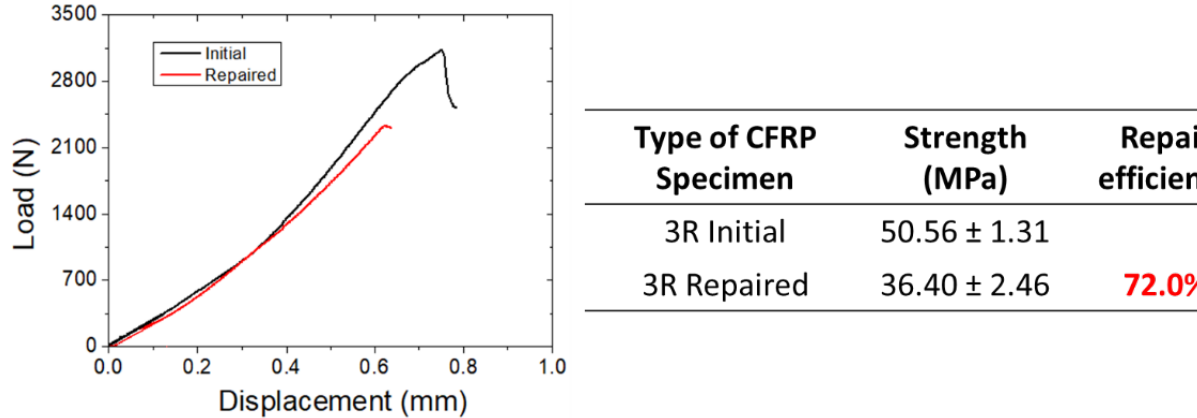
Figure 6. Representative plots of ILSS specimens ( left ) and repair efficiency of maximum strength ( right ).